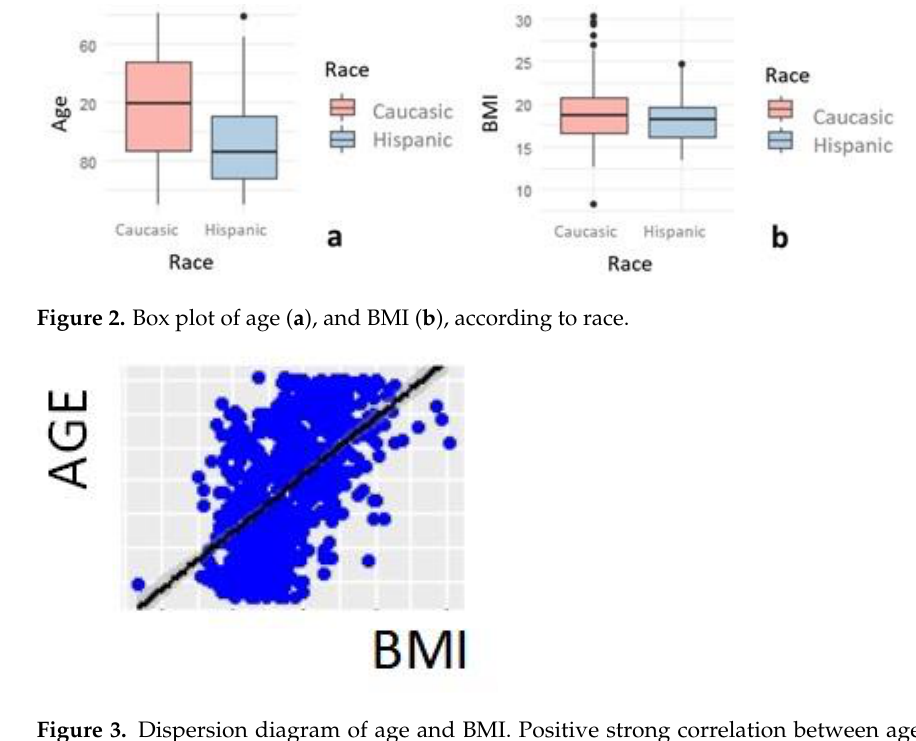
Figure 1. Box plot of age ( a ), and BMI ( b ), according to BMI category.